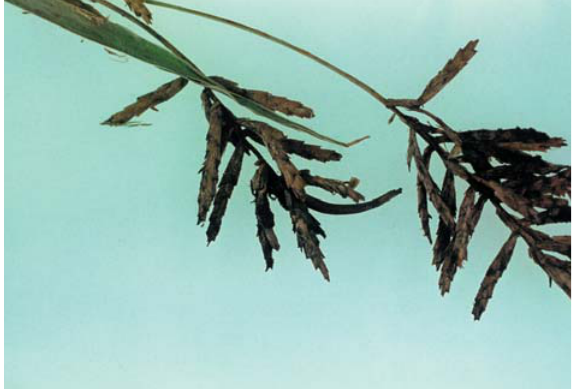
FIG. 9 A flower head of Cyperus esculentus showing a large, curved sclerotium of Claviceps cyperi